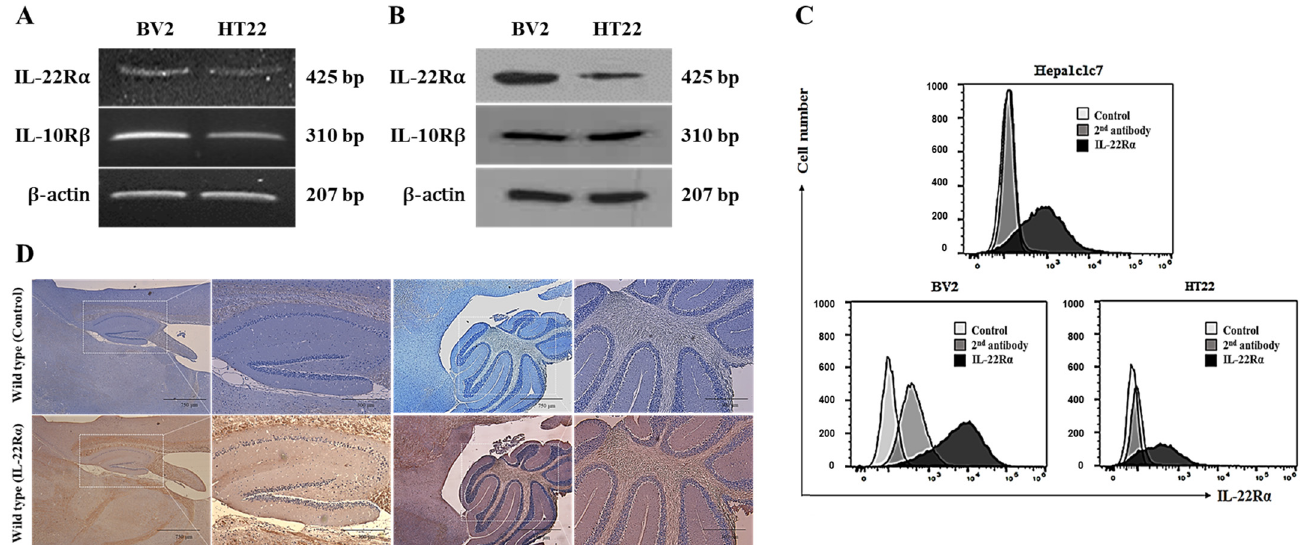
Figure 1. IL-22R α is constitutively expressed in BV2 and HT22 cells and mouse brain tissue. ( A ) RT- PCR analyses of IL-22R α and IL-10R β in BV2 and HT22 cells. Total RNA was extracted from cells (1 × 10 6 ), and RT-PCR was performed using specific primers for IL-22R α and IL-10R β , as described in the Materials and Methods. ( B ) Western blot analyses of IL-22R α and IL-10R β in BV2 and HT22 cells. Protein was extracted from 1 × 10 6 cells and analyzed with -IL-22R α Ab and anti-IL-10R β Ab, as described in the Materials and Methods. β -actin was used as a loading control. ( C ) Flow cytometry analyses of IL-22R α in BV2, HT22, and Hepa1c1c7 cells. For each sample, 1 × 10 5 cells were collected, processed as described in the Materials and Methods, and then stained with an anti-mouse IL-22R α antibody (2.5 µg/10 6 cells) as a primary antibody, and FITC-conjugated anti-rabbit Ab was used as a secondary antibody. IL-22R α expression was analyzed as described in the Materials and Methods. ( D ) Immunohistochemical analysis of IL-22R α expression in mouse brain. Paraffin-embedded tissues were sectioned with 4 µm thickness and incubated with a primary antibody against IL-22R α and then with a biotinylated anti-rabbit antibody. ABC solution was loaded onto the sections for 30 min and a DAB kit was used for chromogenic detection. ( A – D ) Results are representative of three independent experiments.